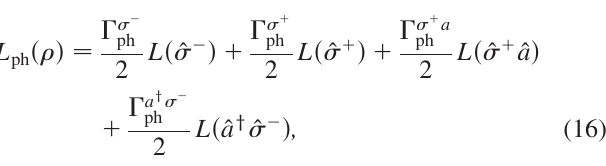
FIG. 2. Schematic of the phonon-scattering processes: (a) (cid:3) (cid:1) þ , ph , (c) (cid:3) (cid:1) þ a , and (d) (cid:3) a y (cid:1) (cid:1) , for a QD-driven system (b) (cid:3) (cid:1) (cid:1) ph ph ph introduced in the effective Lindblad description and defined in Eqs. (18) and (19). The various symbols are the same as in Fig. 1. Processes (a) and (b) describe the phonon-induced incoherent excitation and excitation-induced dephasing; process (c) de- scribes phonon-induced exciton excitation via cavity decay, though this process has a small probability because of a rela- tively large cavity decay rate ( (cid:10) ); process (d) describes phonon- induced cavity excitation through the decay of an exciton; at low temperature this (cavity-feeding) process occurs primarily via phonon emission, and will be more efficient for a cavity mode that is red shifted with respect to the exciton. The sign of the cavity detuning in (c)-(d) is just an example, and note that the ¼ (cid:1) or (cid:1) ¼ (cid:1) (cid:1) will be differ- phonon interactions with (cid:1) cx cx ent (especially at lower